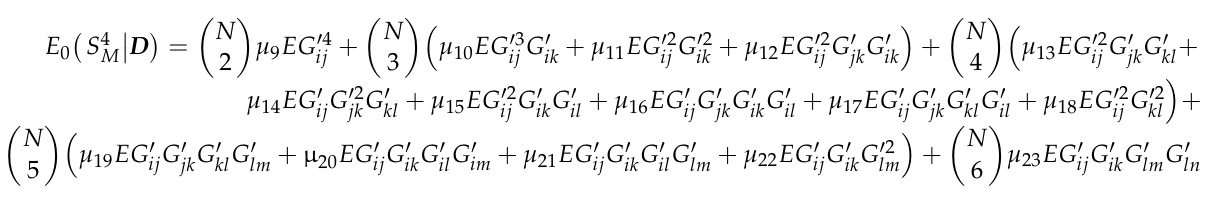
(cid:54) = 0. G (cid:48) G (cid:48) G (cid:48) mn xy st ij